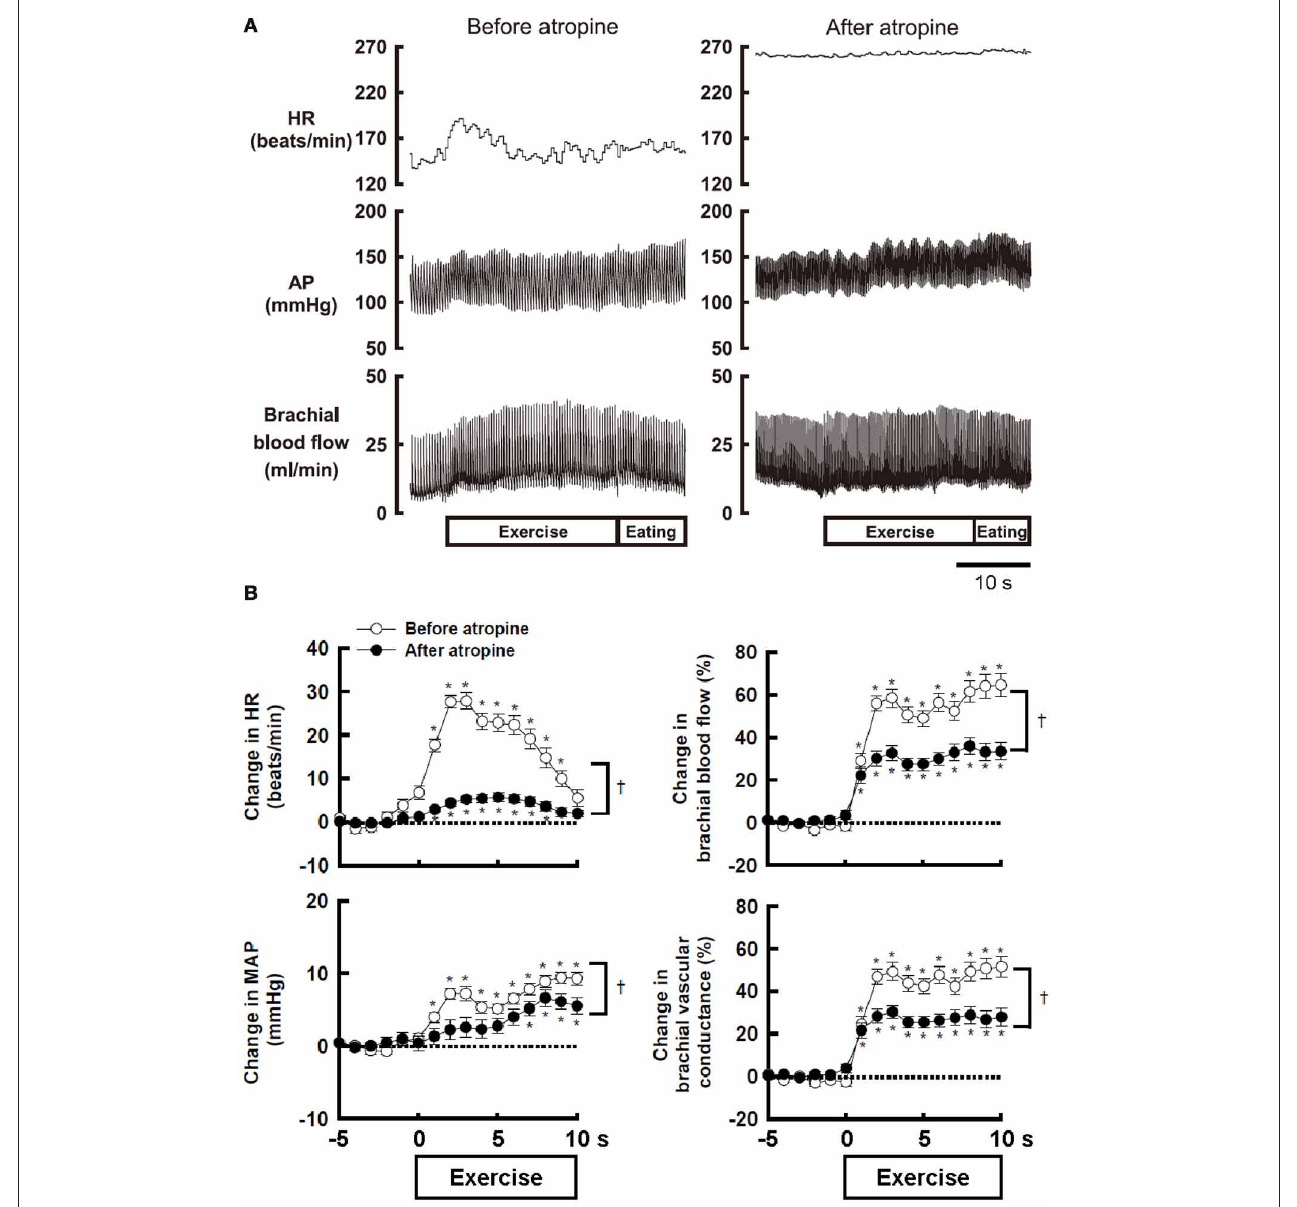
FIGURE 1 | (A) The effect of atropine on the responses in heart rate (HR), arterial blood pressure (AP), and brachial blood flow during voluntary static exercise in a conscious cat. In the presence of atropine, the increase in brachial blood flow was blunted, although the baseline blood flow was not altered. (B) The effect of atropine on the average responses in HR, mean arterial blood pressure (MAP), brachial blood flow, and brachial vascular